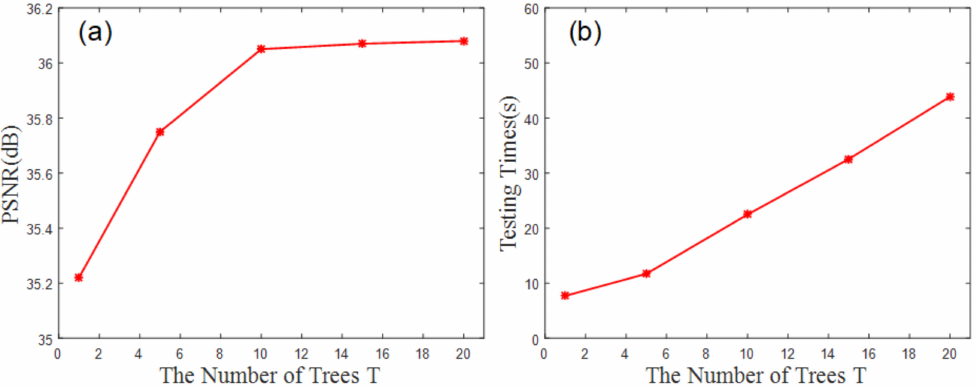
Figure 8. As shown in ( a ), when T = 10, the PSNR is close to saturated; in ( b ) the time increases linearly as T